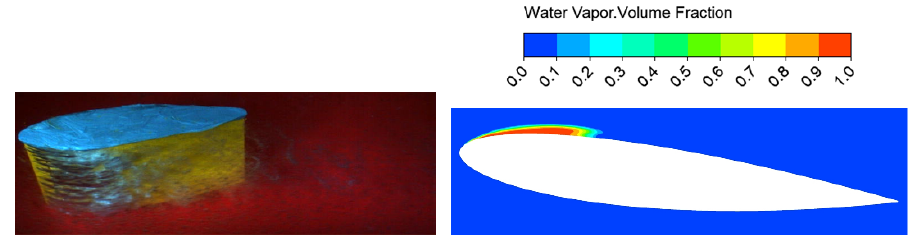
Figure 4. Numerical results and experimental data for σ = 1.075.